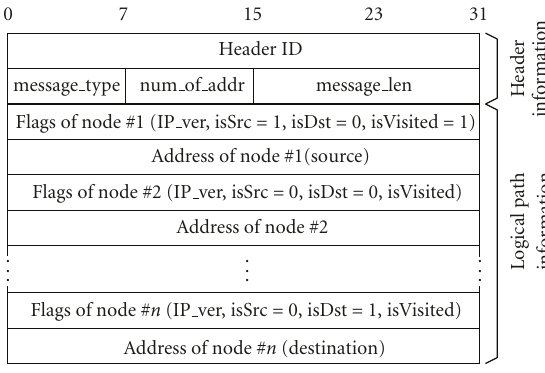
Figure 4: LR header